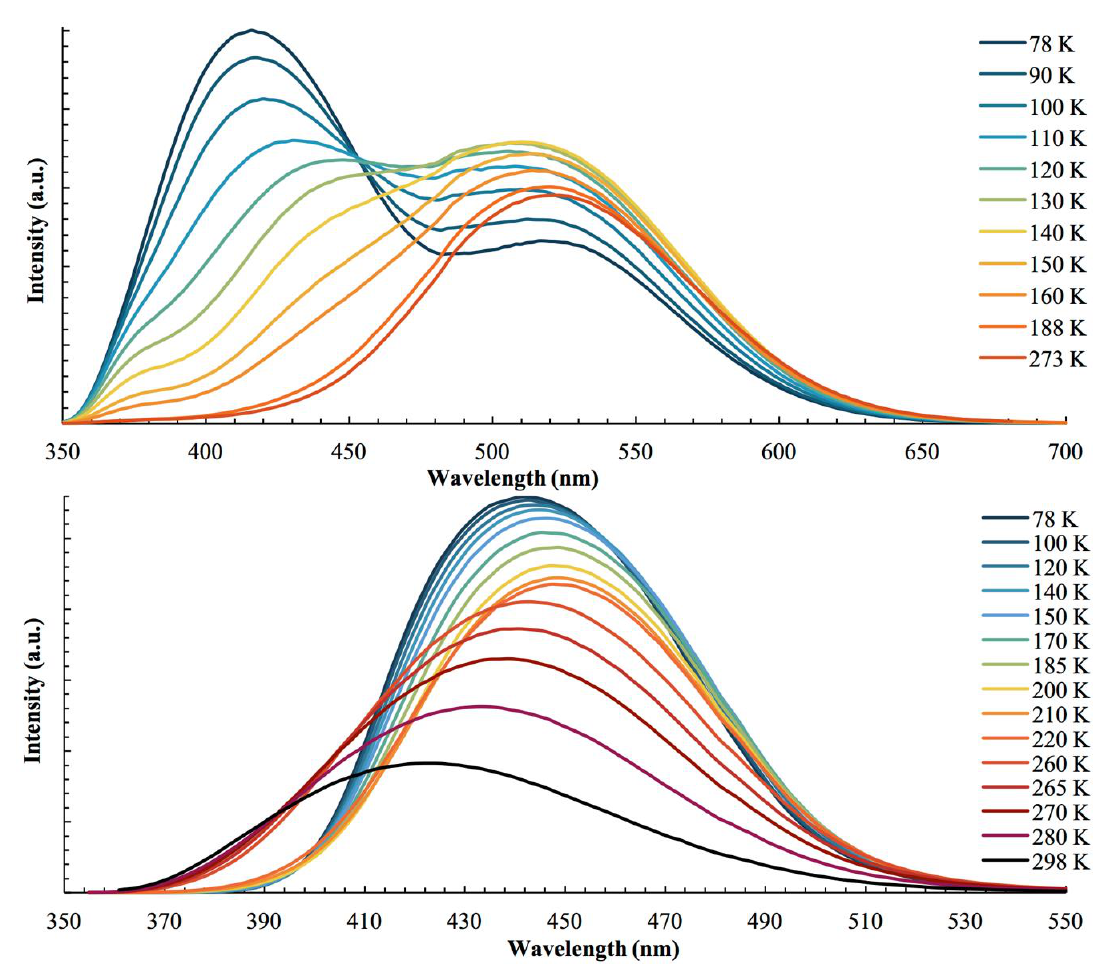
Figure 6. Luminescence spectra of 1 (top) and 2 (bottom) between 78 K and 298 K. The emission was measured at λ ex = 315 nm and λ ex = 330 nm for 1 and 2 , respectively. Table 2. Summary of luminescence spectra of 1 and 2 between 78 K and 298 K.